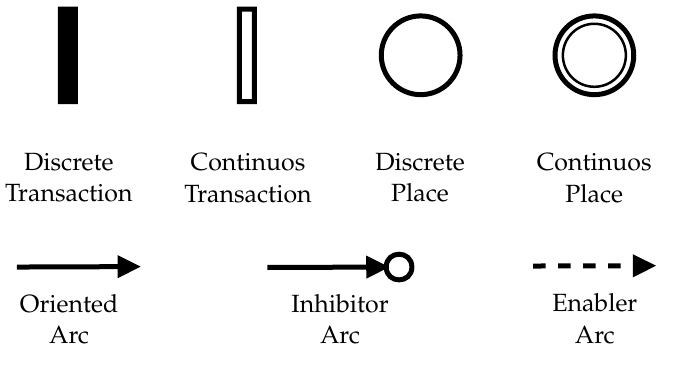
Figure 2. Basic elements of the HPN. The HPN is the lowest level and implements the control algorithm. The continuous transaction and place are responsible of processing continuous values in the HPN. The inhibitor and enabler arcs define a specific flow and consequently enable/disable specific activities. The VAD control is implemented using the